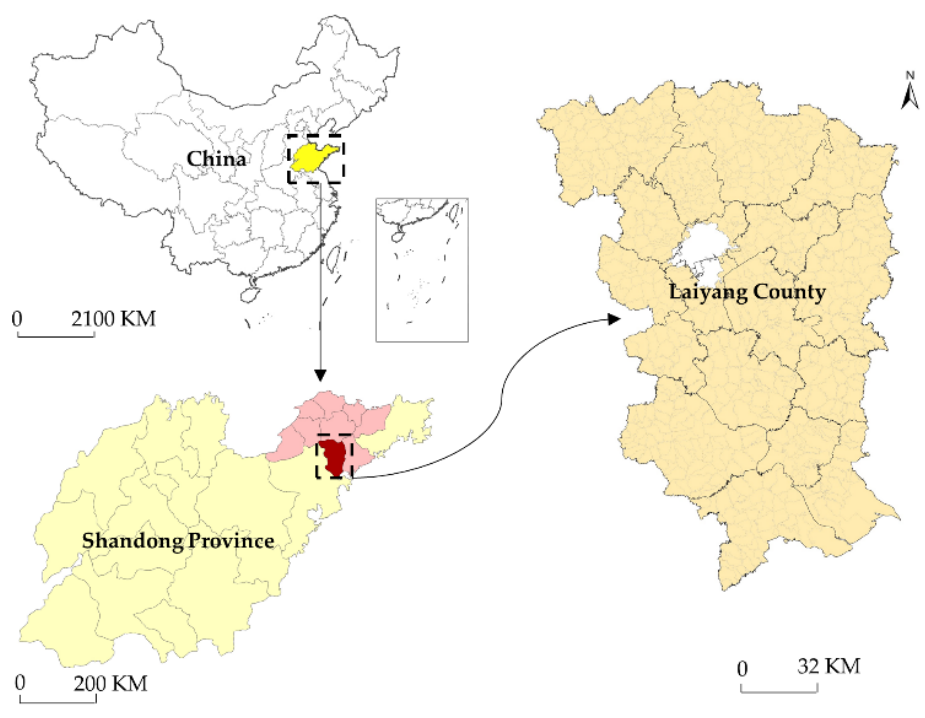
Figure 2. Location of the study